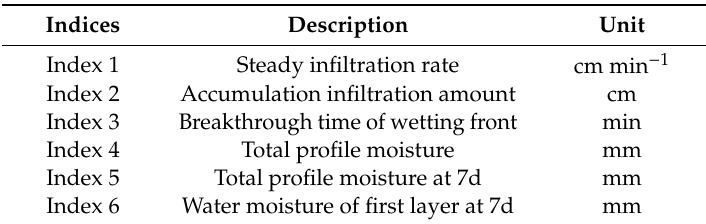
Table 7. Selected indices for soil profiles.